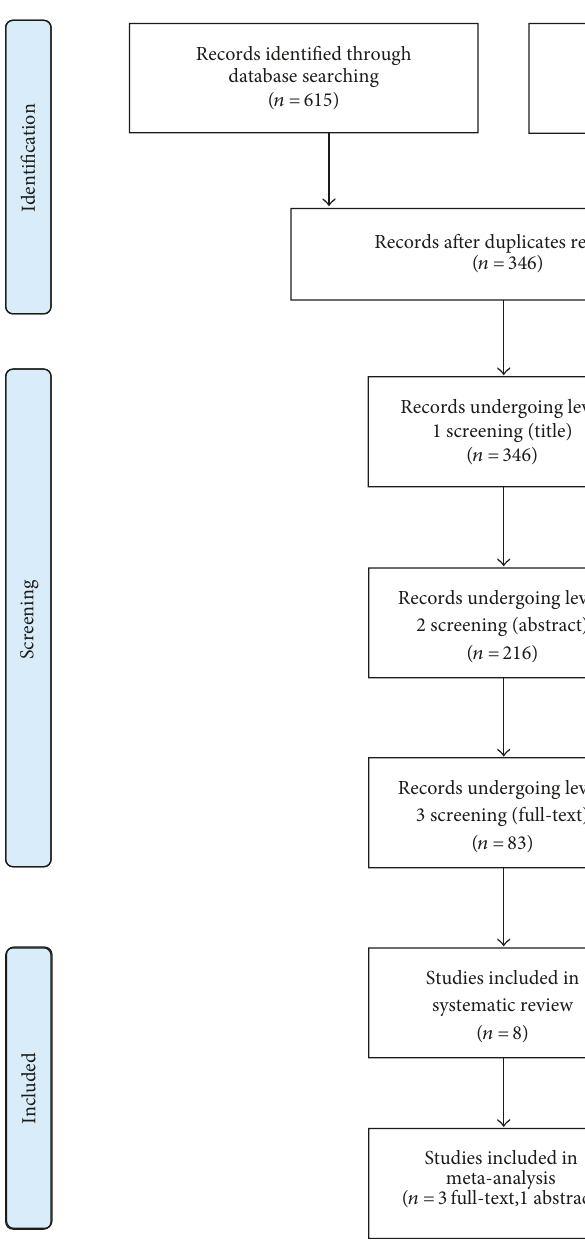
Figure 1: PRISMA fl ow